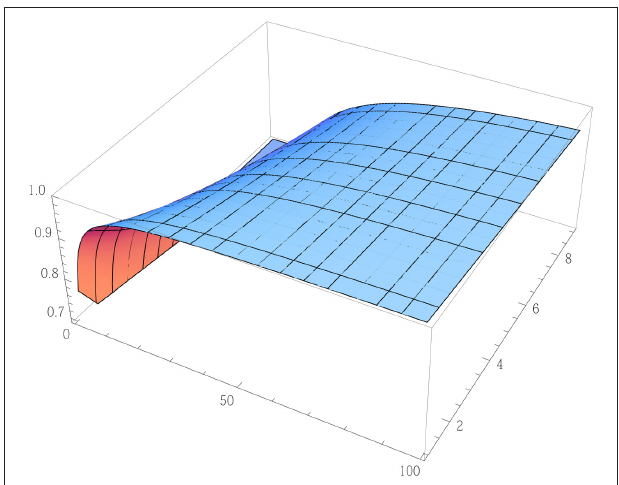
FIGURE 6 | Ideal case fidelity of counterfactual transport. The fidelity of our protocol for counterfactually transporting an unknown qubit plotted against the number of outer and inner cycles, M and N , for M up to 10 and N 1 . Implementation imperfections are up to 100, with α β √ 2 = =